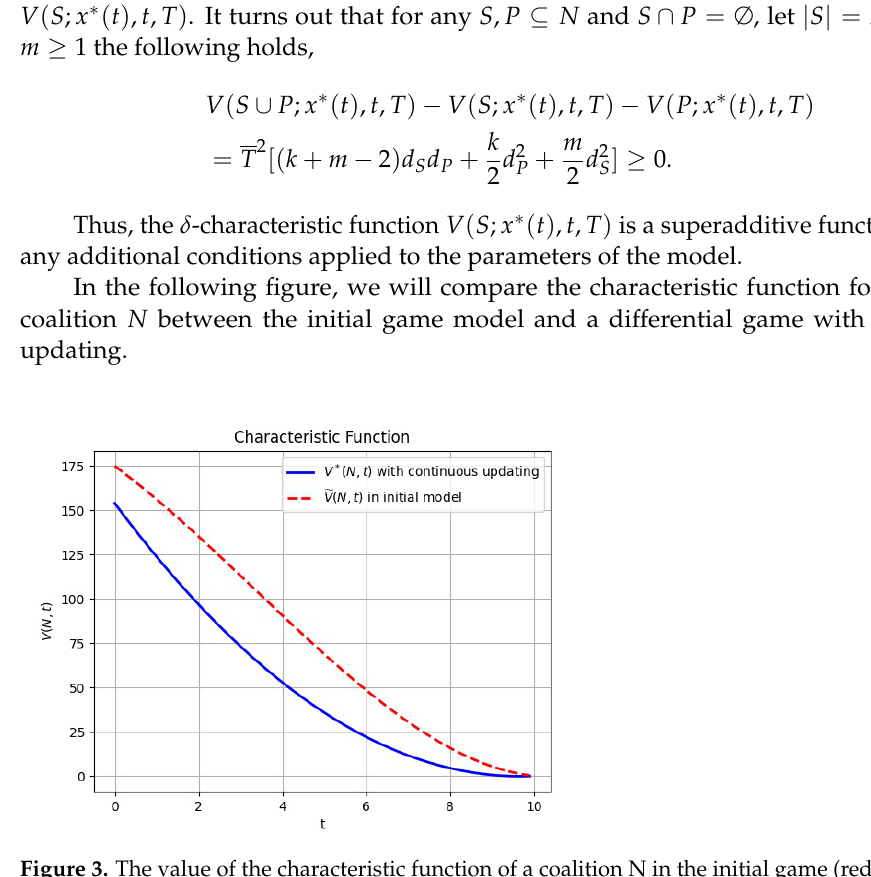
Figure 3. The value of the characteristic function of a coalition N in the initial game (red line) and the value of the characteristic function of a coalition N with continuous updating V ∗ ( N , t , T ) (blue